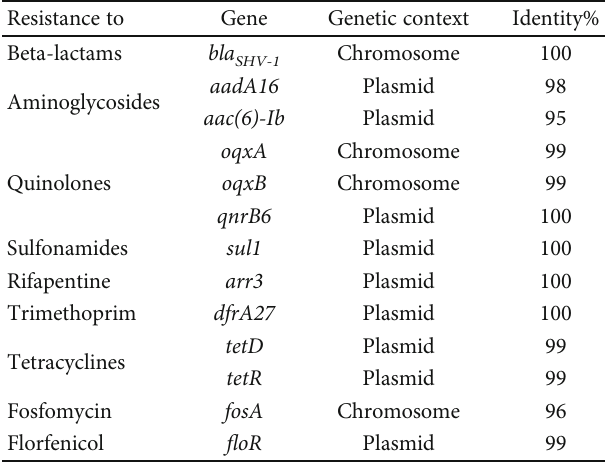
Table 1: Antibiotic resistance gene of